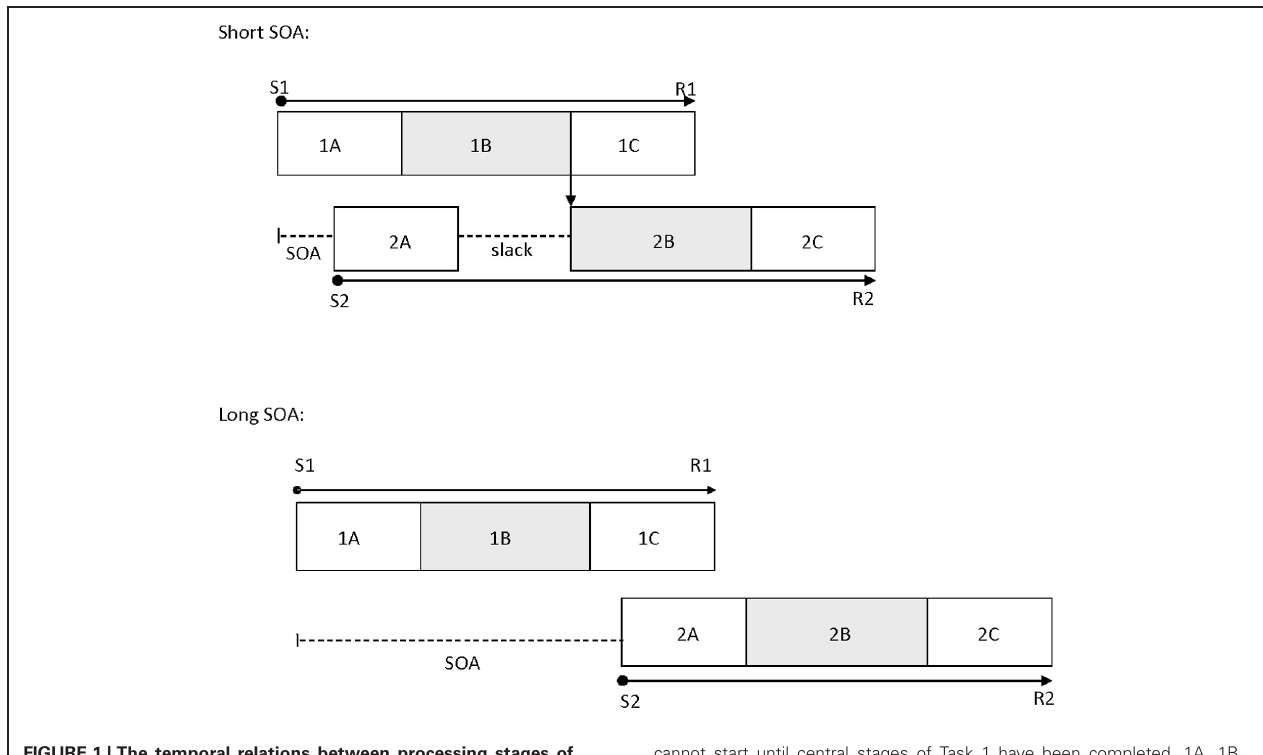
FIGURE 1 | The temporal relations between processing stages of Task 1 and Task 2 at a short SOA (top panel) and a long SOA (bottom panel) in the psychological refractory period paradigm, as suggested by the central bottleneck model. This model assumes that perceptual and response initiation/execution stages of Task 2 can operate in parallel with any stage of Task 1, but that central stages of Task 2